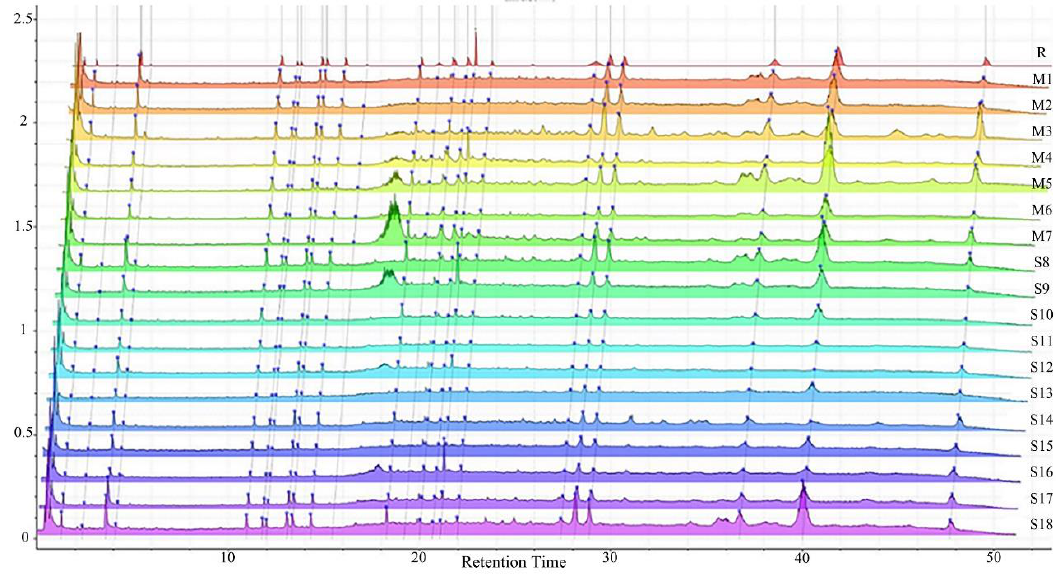
Figure 1. Chromatography fingerprint of 18 batches of samples.